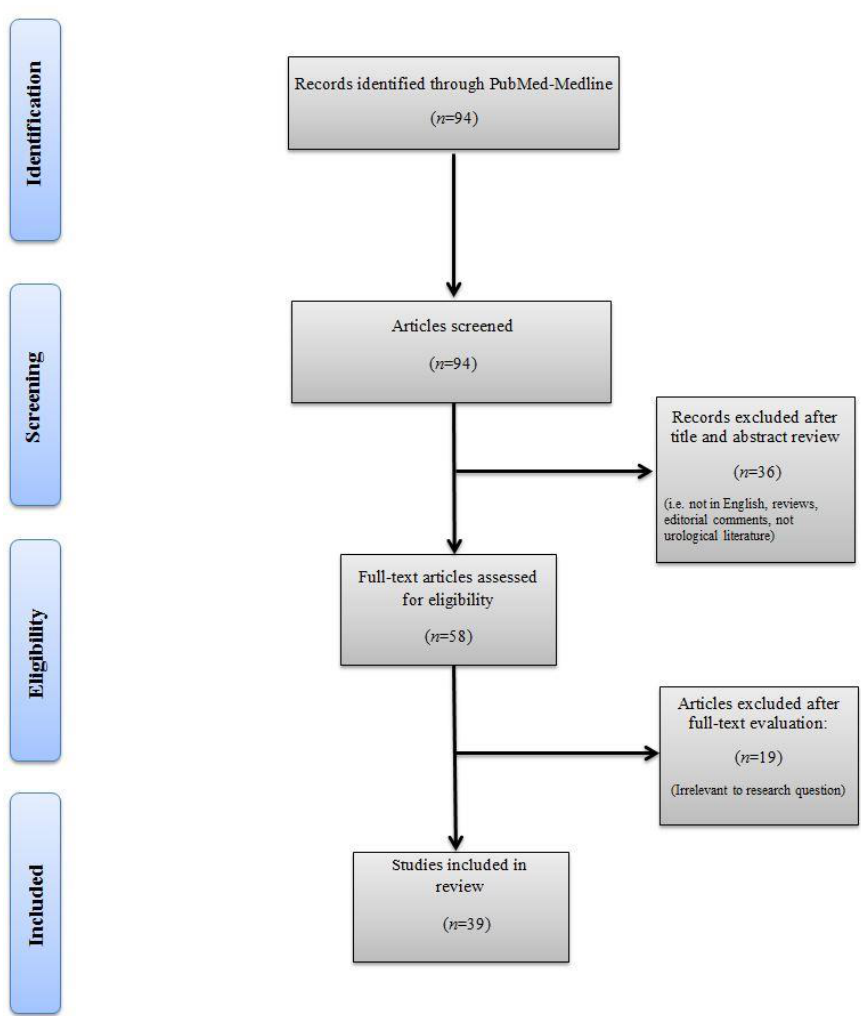
Figure 1. Summary of study selection process.